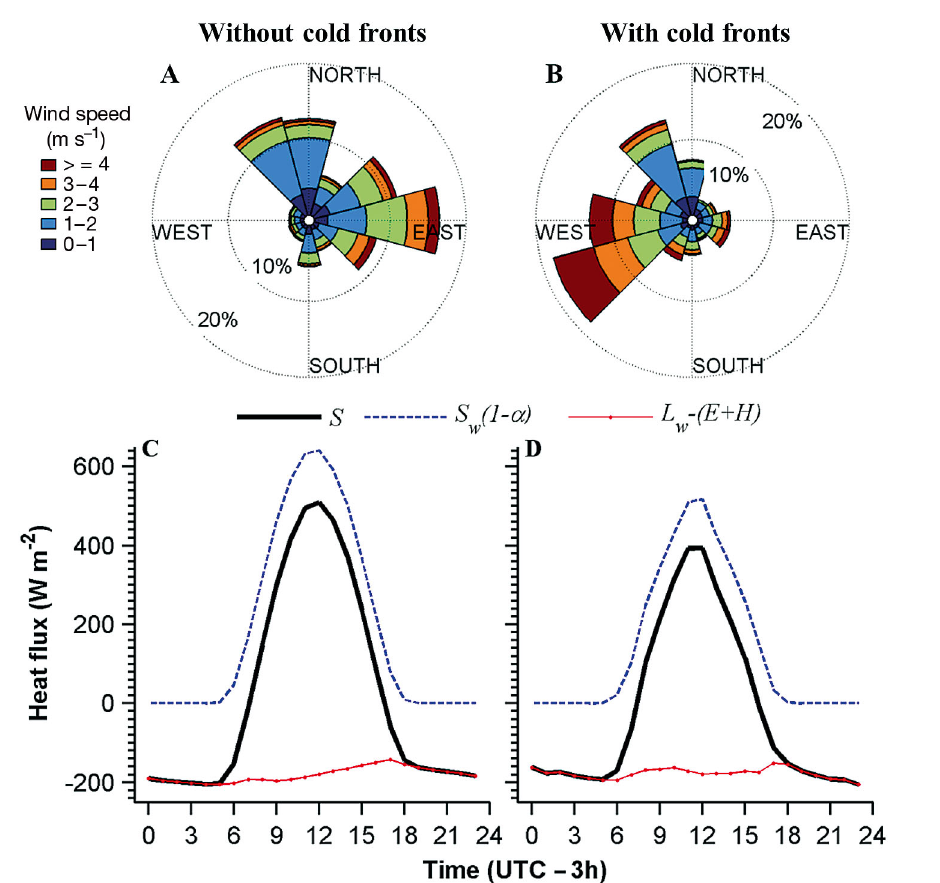
Fig. 6. (A,B) Wind direction and speed frequency distribution, and (C,D) diel variability of surface heat flux balance ( S) , shortwave radiation ( S w ) multiplied by 1 minus the albedo ( α ), and net longwave radiation ( L w ) minus latent ( E) and sensible ( H) heat fluxes, for days (A,C) without and (B,D) with cold front passages